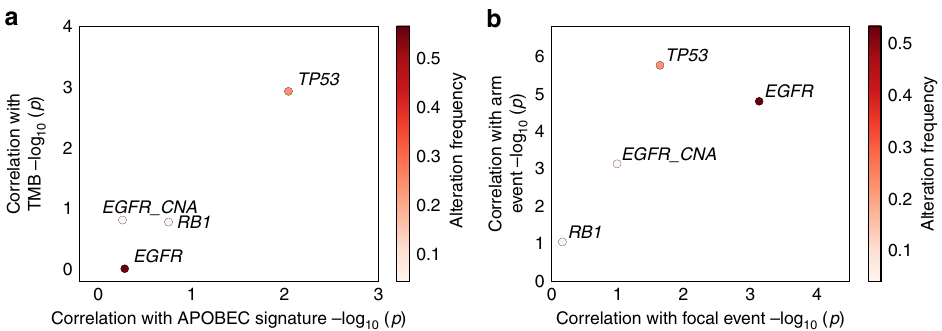
Fig. 2 Correlation of somatic alterations with genomic features. TP53 , EGFR , RB1 mutations and EGFR ampli fi cation in correlation with a TMB and APOBEC signature, and b arm and focal CNA. Student ’ s t test was used to calculate the log 10 -transformed p value. Samples in all stages were included to calculate the alteration frequency. Source data are provided as a source data fi le.